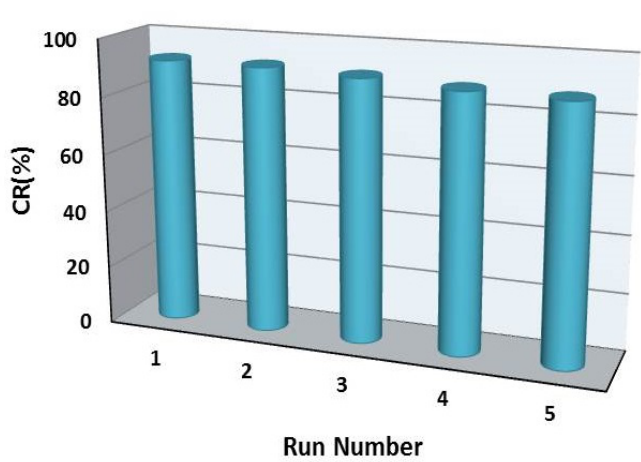
Fig. 10. Reusability results of Yb 0.04 Zn 0. 96 S in photocatalytic decolorization of 10 mg/L of Yellow 5 in the presence of 1.0 g/L of Yb 0.06 Zn 0. 94 S and irradiation time of 100 min